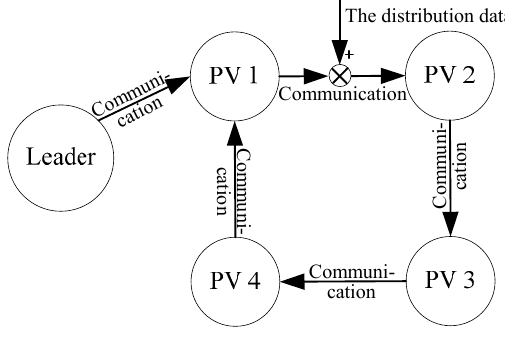
Figure 6. The related communication topology of PVs.